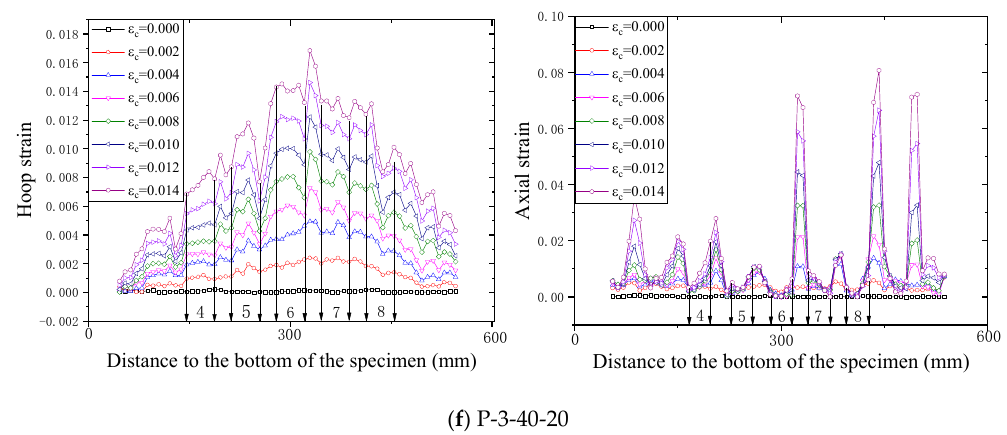
Figure 14. Strain distribution along the specimen height using the PIV sensing technique ( ε c = axial strain of concrete).